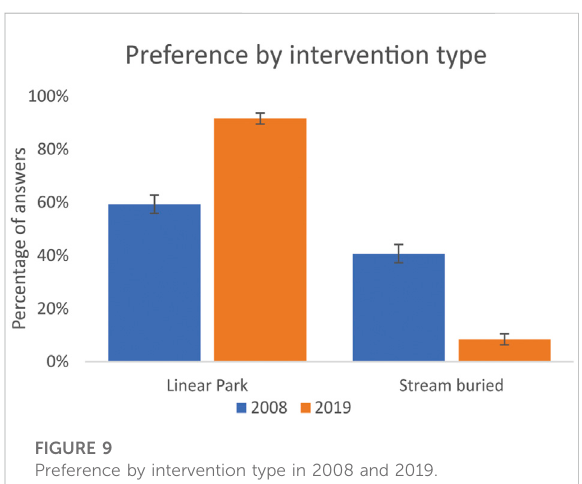
FIGURE 9 Preference by intervention type in 2008 and